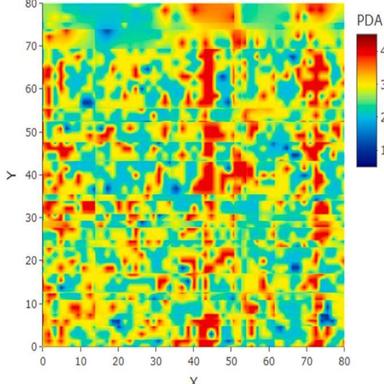
Mechanical phase map produced by PDA analysis for the preliminary annotation of nanoindentation data. X and Y coordinates are presented in µm.